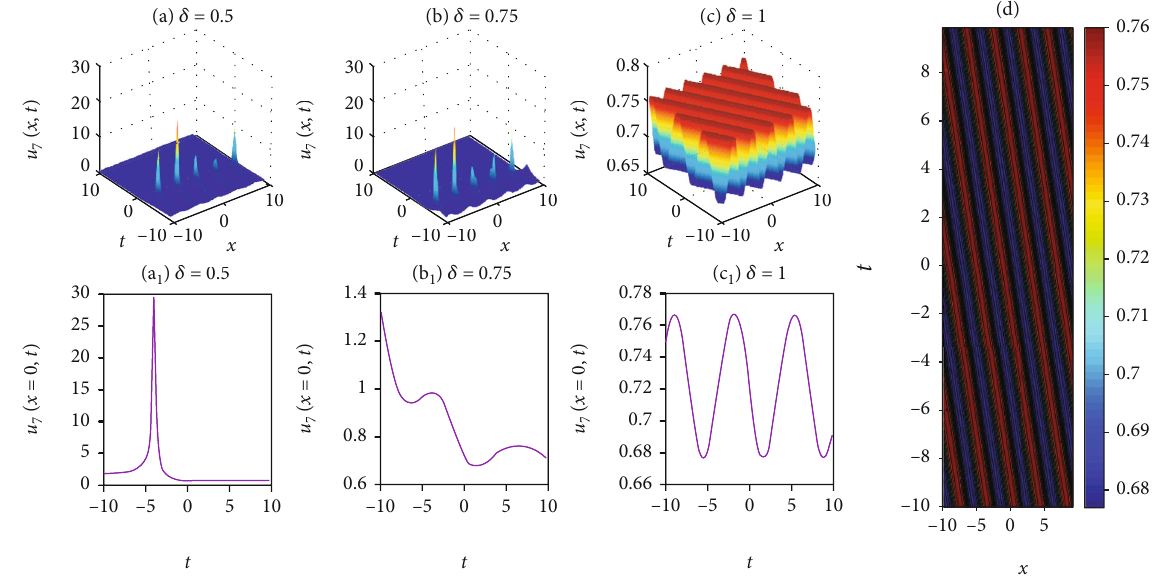
ð x , t Þ . (a – c) 3D plots. (a 7